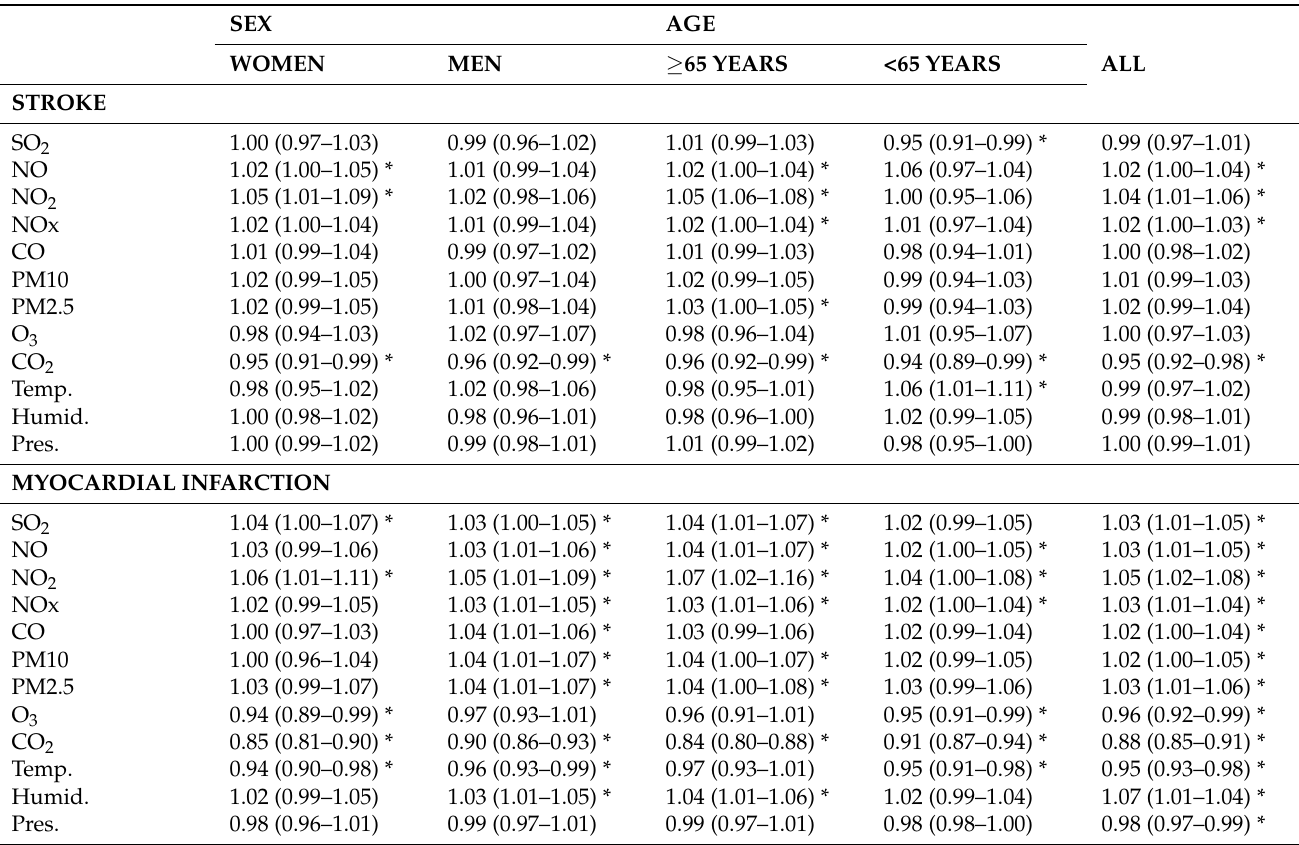
Table 4. Relative risk of stroke and myocardial infarction for IQR changes in air pollutant level, 10 ◦ C in temperature, 5% in humidity and 5 hPa in atmospheric pressure obtained from simple regression models (with one